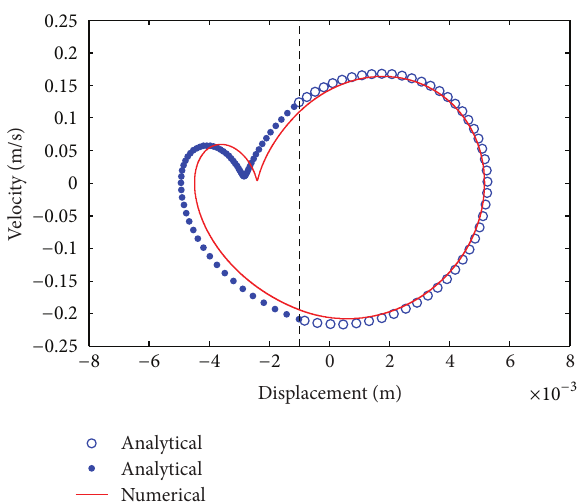
Figure 8: Comparison of the periodic orbits of 1/2 subharmonic resonance response between the approximate and numerical solutions at 𝜔 = 56.55 rad/s.